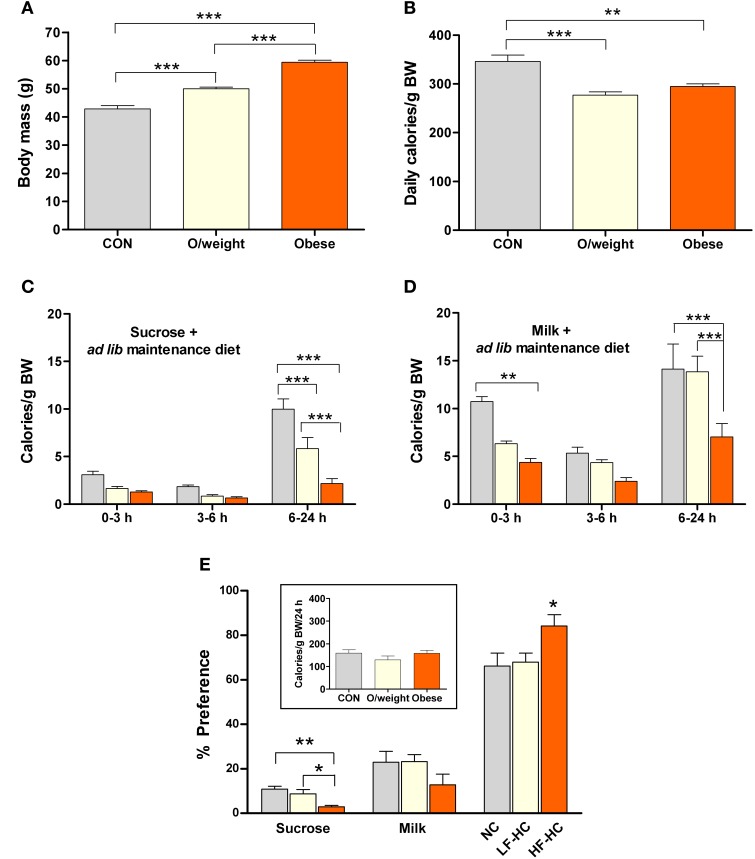
Mice of differing body masses are sensitive to the rewarding properties of both, low-calorie foods (isocaloric 15% sucrose solution and milk containing 5% fat) and energy-dense solid chow. Ingestion of the different foods was monitored in control (CON, n = 15), overweight (O/weight, n = 18) and obese (n = 14) mice during hours 0–3, 3–6, and 6–24 of presentation of the liquid foods and their maintenance solid diet (NC, LF-HC, HF-HC). (A) Body masses of the 3 groups of mice at the start of the experiment. (B) Average daily ingestion of calories from maintenance diets, corrected for body weight; data from 3 consecutive 24 h periods. (C,D) Body mass-corrected calories derived from sucrose or milk consumption over a 24 h period. (E) Preferences of CON, O/weight and obese mice for sucrose, milk and maintenance diet. The inset shows the total amount of energy ingested (maintenance diet + sucrose + milk) over 24 h. Depicted data are means ± s.e.m. *, **, ***Represent significant differences between indicated groups at p < 0.05, 0.01, and 0.001, respectively.